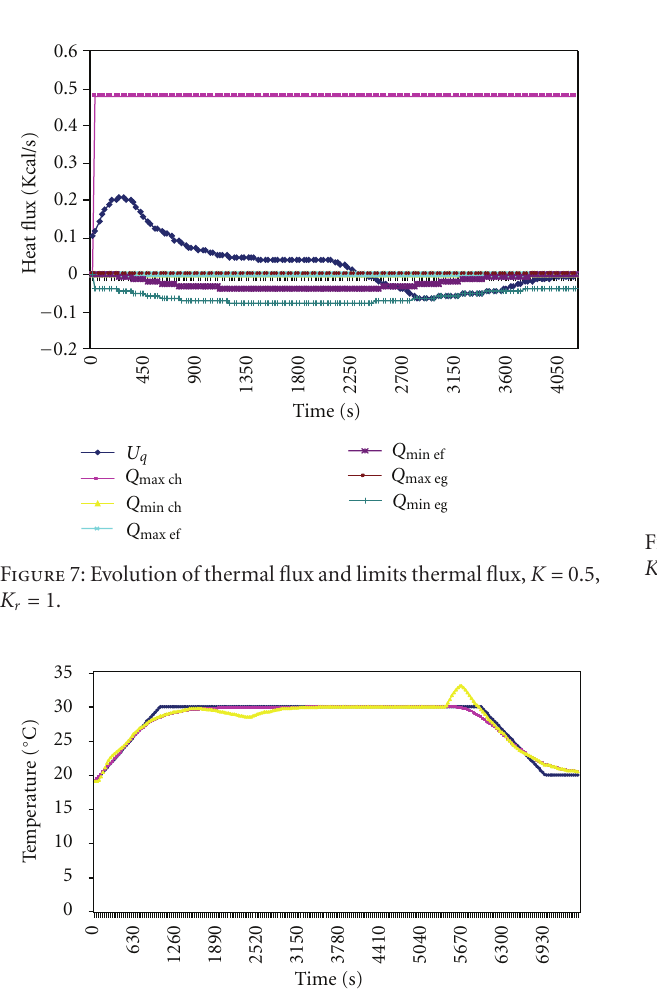
Figure 10: Evolution of the manipulated variable ( β ), K = 1, K r =